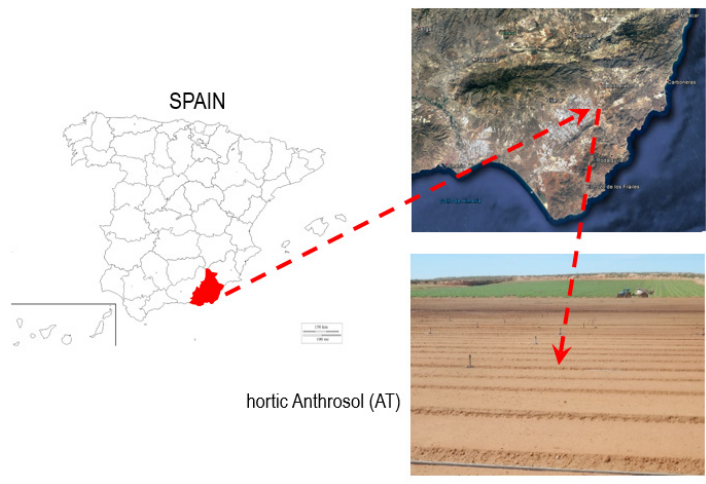
Figure 1. Location of study area.